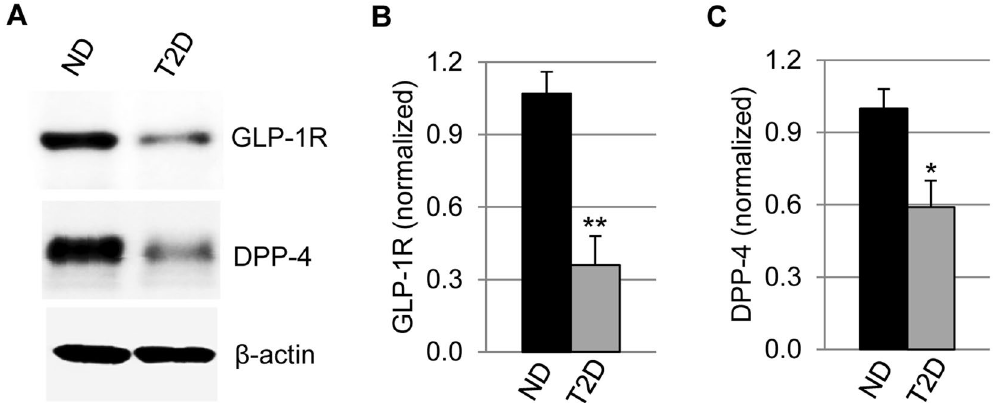
Figure 4. GLP-1R and DPP-4 expression in ND and T2D human islets. ( A ) Western blotting assay examining GLP-1R and DPP-4 expression in the lysates of ND and T2D islets. Beta-actin was included as loading control and reference for quantification. Shown are cropped images, and the full-length blots are included in the supplemental information. ( B ) Quantification of GLP-1R band signal that was normalized to β -actin signal (n = 5 for each group). ( C ) Quantification of DPP-4 signal normalized to β -actin (n = 5). The data were expressed as Mean ± SEM. * p < 0.05, and ** p <